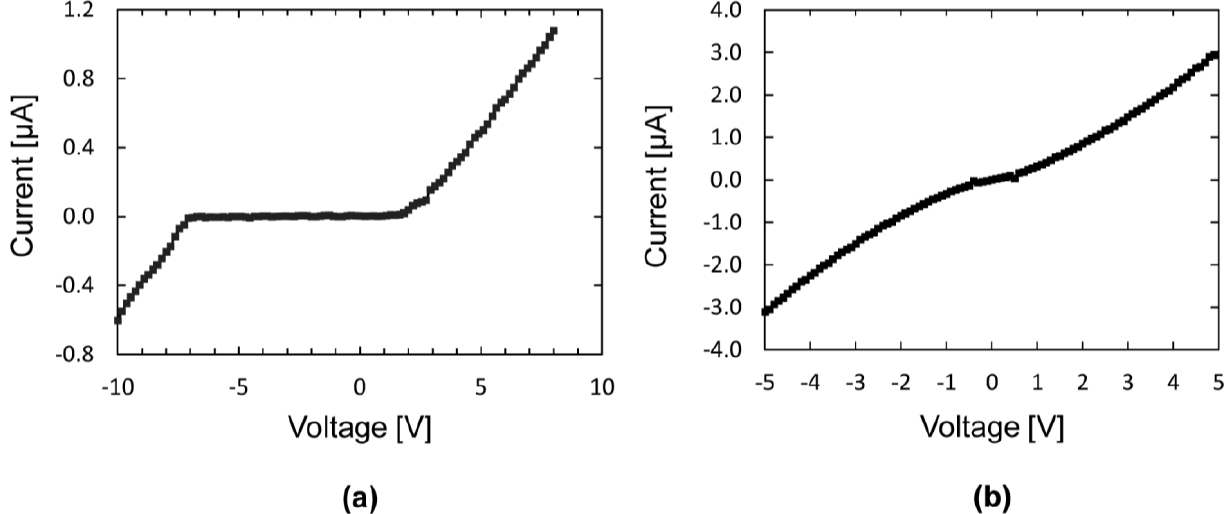
Figure 7. Measured current-voltage relationship for two Si/CNT/Si systems. ( a ) Rectifying characteristics, having a conducting region for voltages less than −7 V and greater than +2 V; ( b ) Near-ohmic characteristics with deviations from a linear behavior similar to ( a